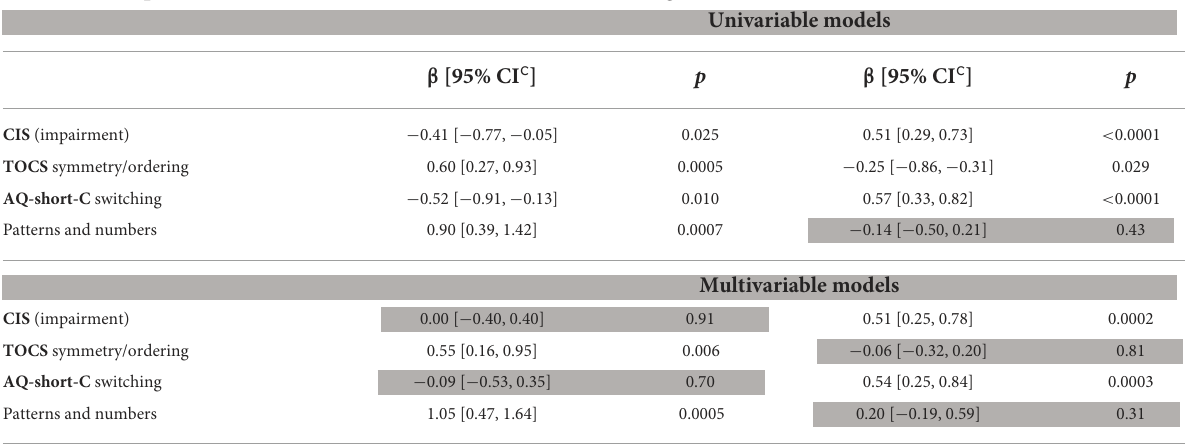
TABLE 2 Effect of SWAN attentional strength scores and SWAN attentional weakness scores in the ASD sample, univariable and multivariable models a . Outcomes b (dependent